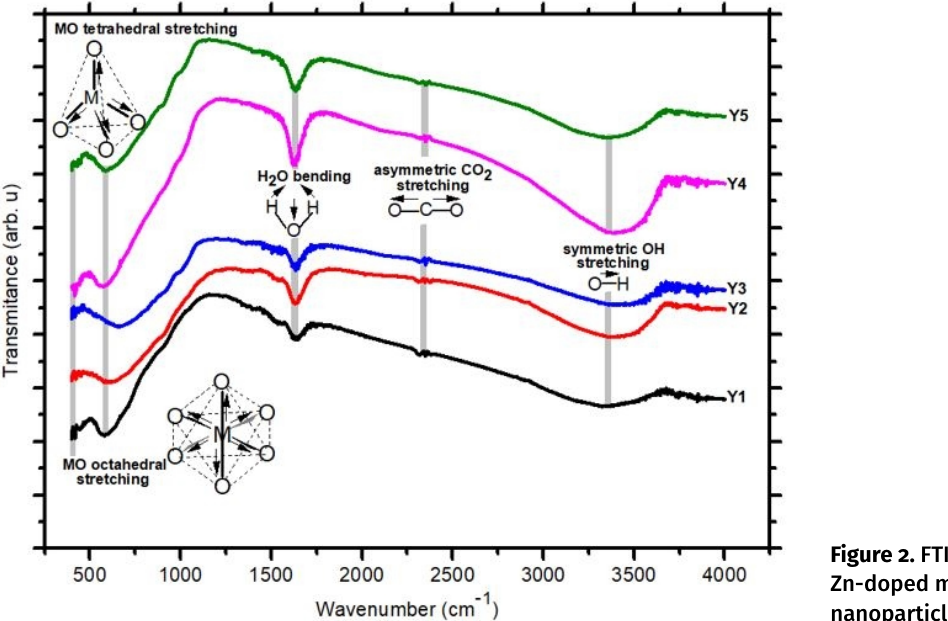
Figure 2. FTIR spectra of the Zn-doped magnetite